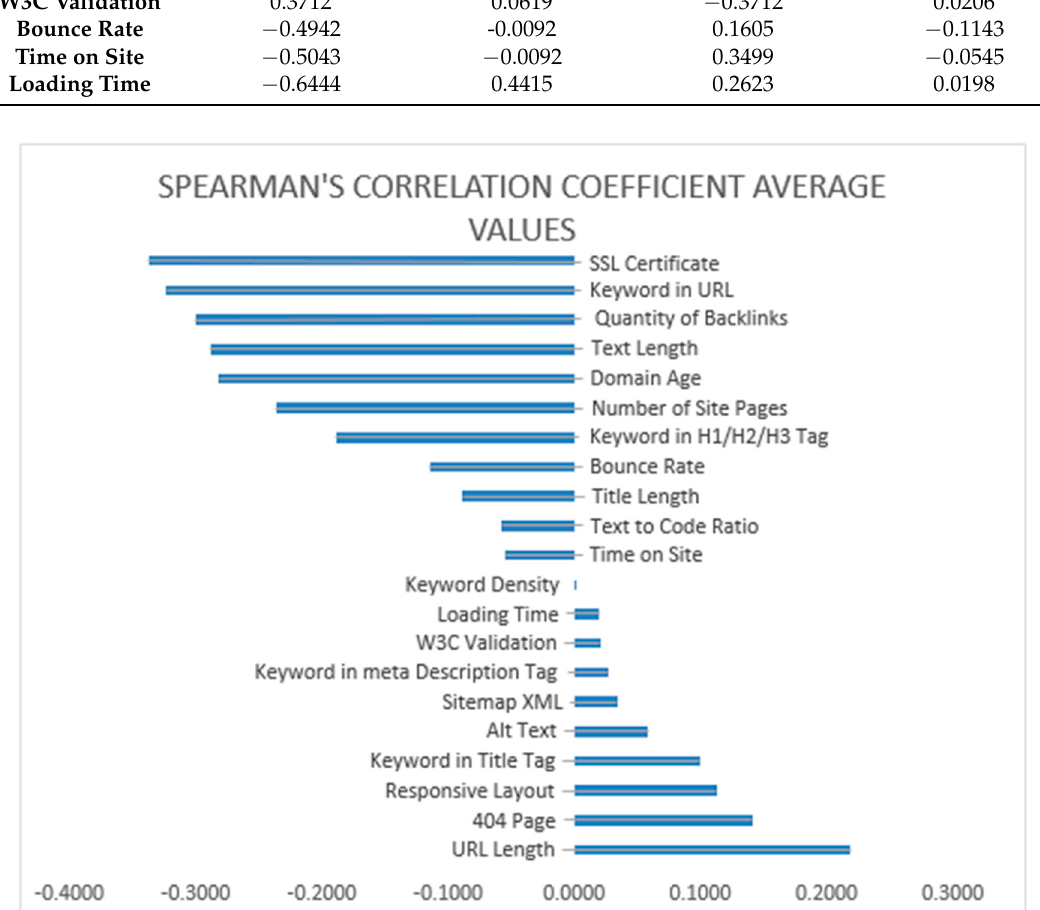
Figure 2. Spearman’s correlation coefficient average values.